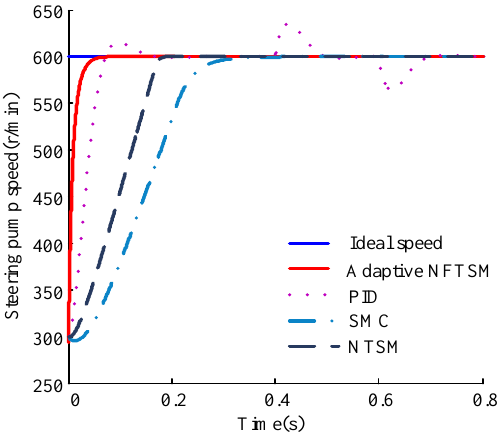
Figure 14. Speed response when input speed is changed.